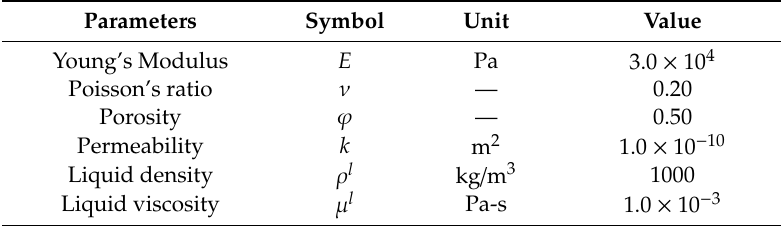
Table 1. Physical parameters for 1D Terzaghi’s